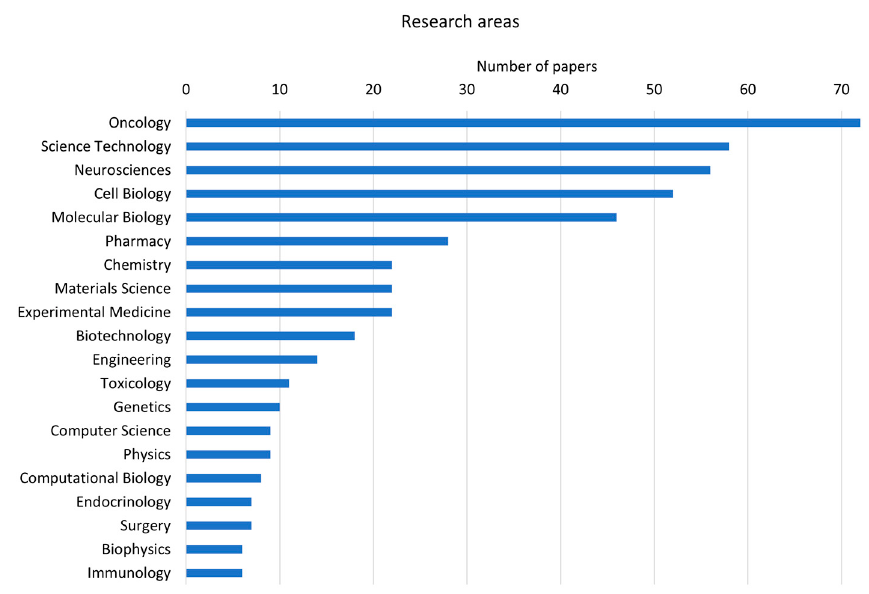
Figure 1. Bar chart of the first 20 research areas to which the papers retrieved from the literature search belong (data derived from Clarivate Web of Science, Copyright Clarivate 2022. All rights reserved).